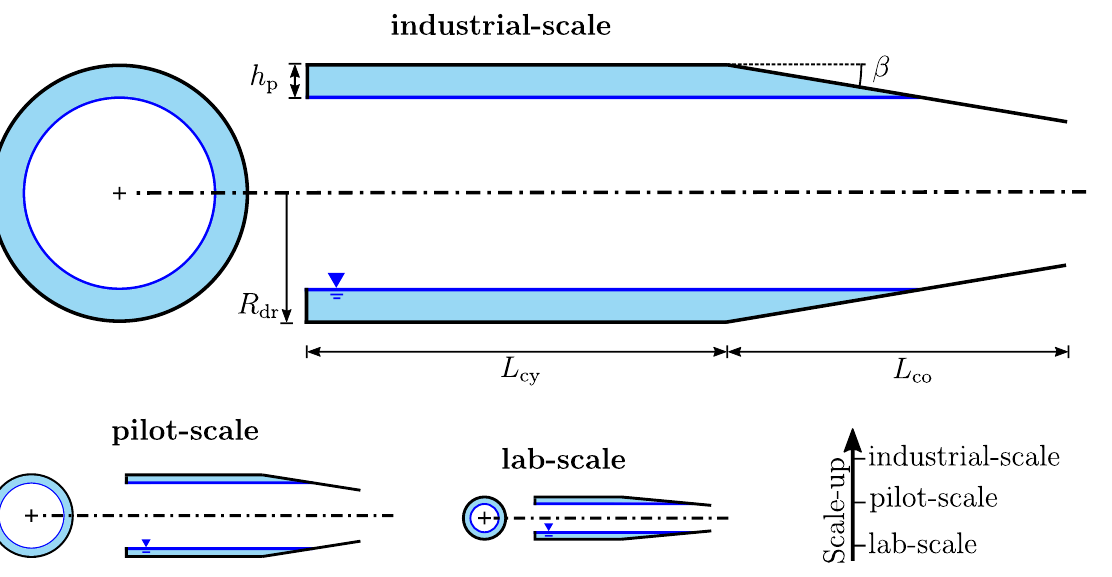
Figure 5. Three sizes of the used decanter centrifuges true to